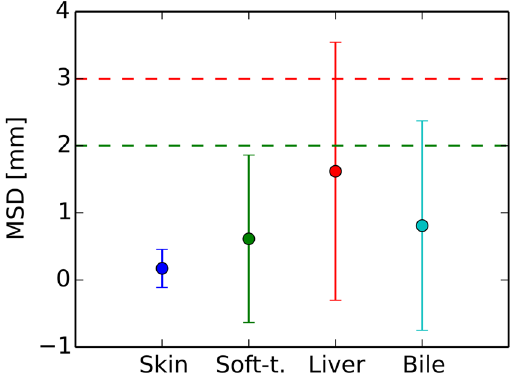
Figure 4. Mean and standard deviations of per path mean surface distances (MSD). Skin tissue depth lags are best. A depth lag of 2 mm (dashed green line) is considered a low just noticeable spatial error for salient needle force events to occur.